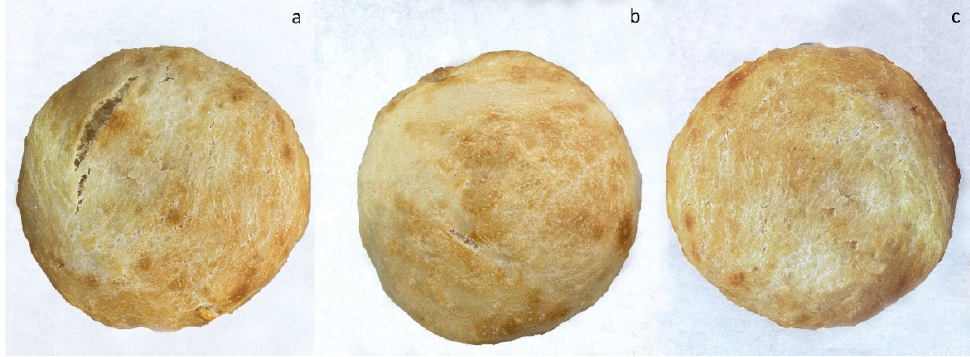
Figure 3. ( a ) Focaccia with olive oil; ( b ) focaccia with durum wheat oil; ( c ) focaccia with sunflower oil.